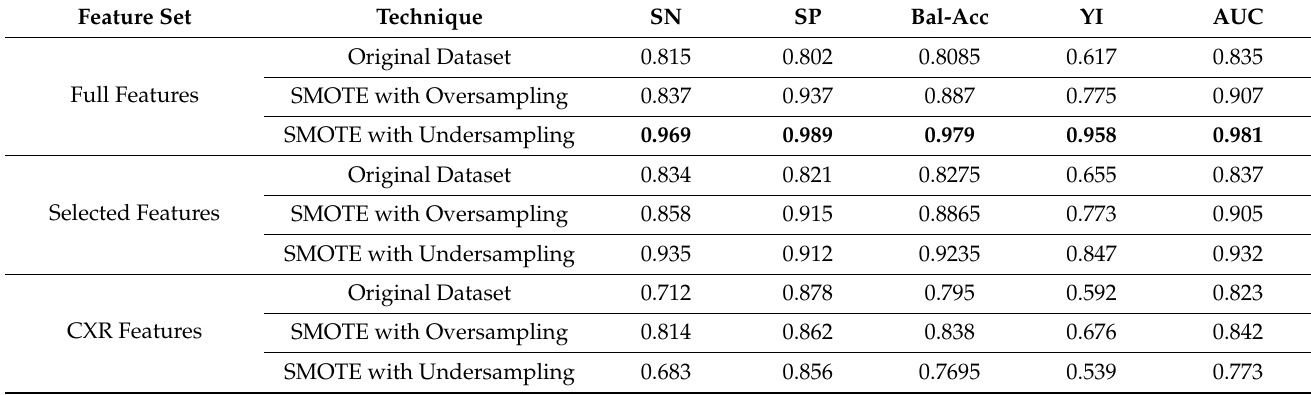
Table 3. Result of the proposed model for ventilator-support prediction (Multiclass) (Case